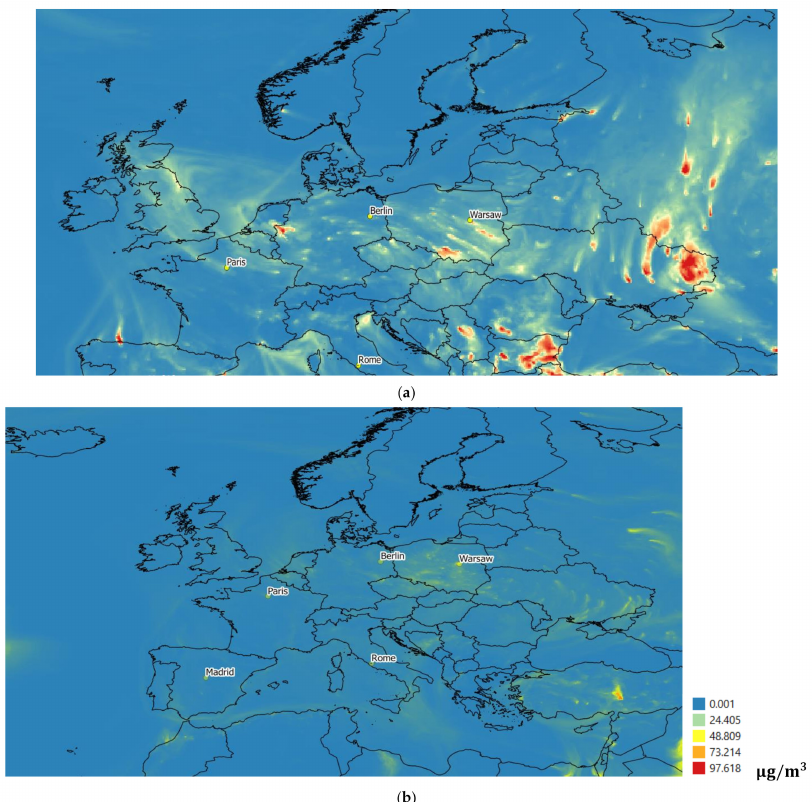
Figure 14. Thermal maps of SO 2 concentration on ( a ) 5 April 2018 and ( b ) 5 April 2020. Source: Own elaboration, based on data from Copernicus Atmosphere Monitoring Service (CAMS) [47].